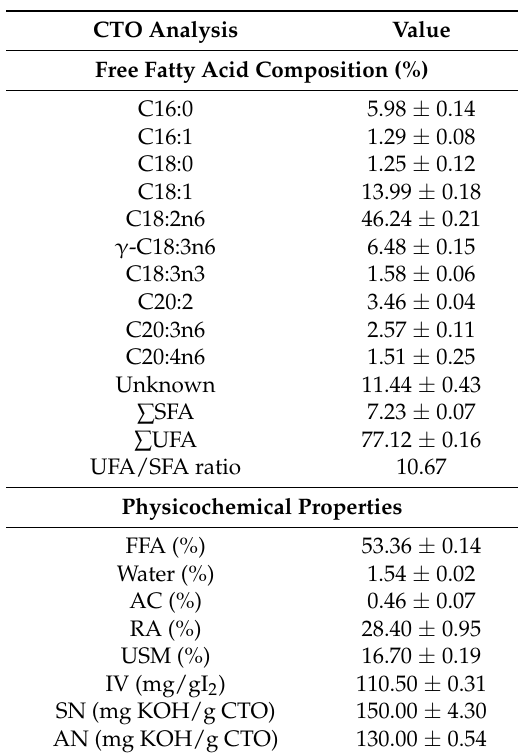
Table 1. CTO physicochemical properties.